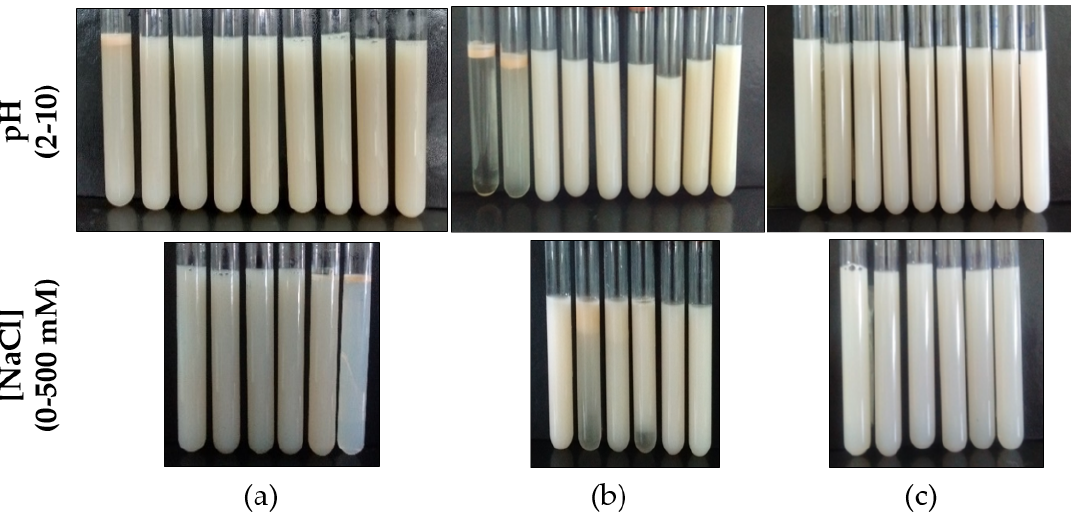
Figure 3. Photographs of emulsions prepared with ( a ) Quillaja saponaria , ( b ) Chenopodium quinoa , or ( c ) Tween 20 after incubation for 24 h with different environmental conditions: pH (2–10) or ionic strength (0–500 mM NaCl).